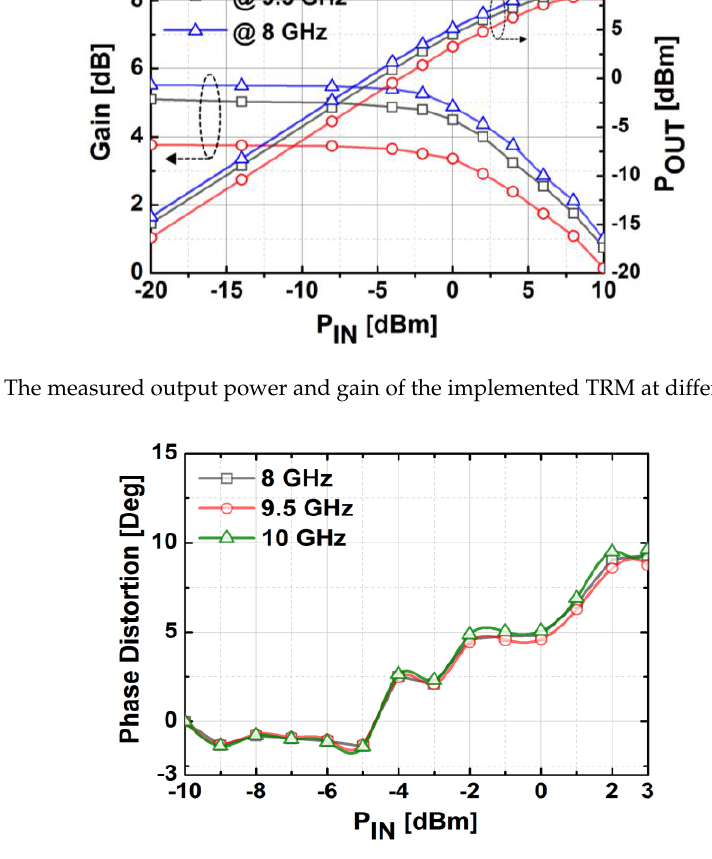
Figure 23. The measured AM/PM conversion of the implemented TRM at different frequencies.